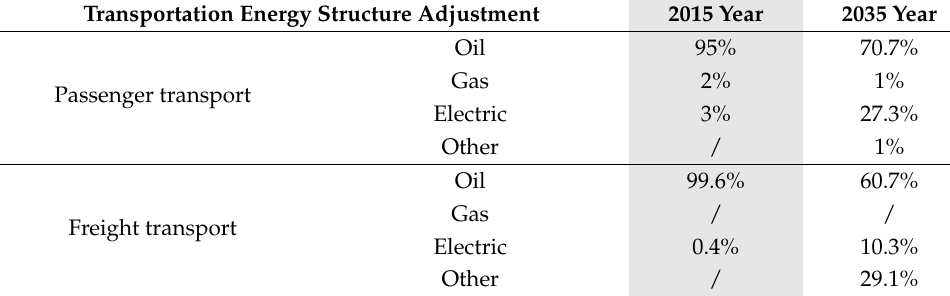
Table A4. Energy structure adjustments in the transportation sector.